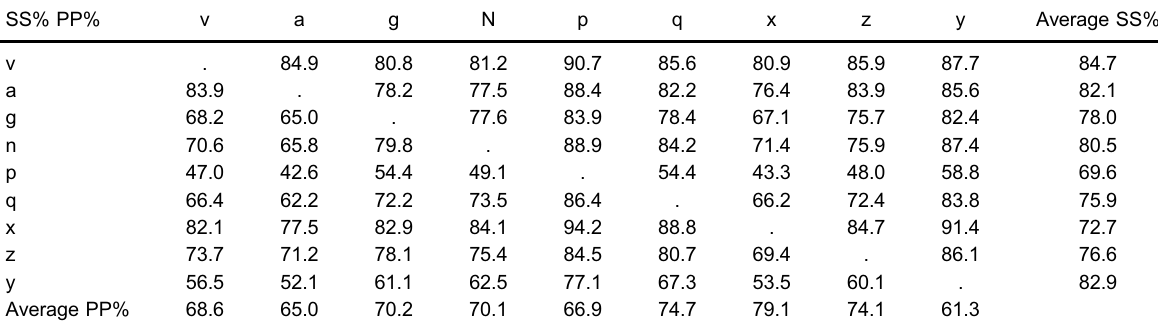
All fi les average sensitivity (upper triangle) and positive predictive values (lower triangle). Last column and last line represent inter- scorers average sensitivity and positive predictive values.